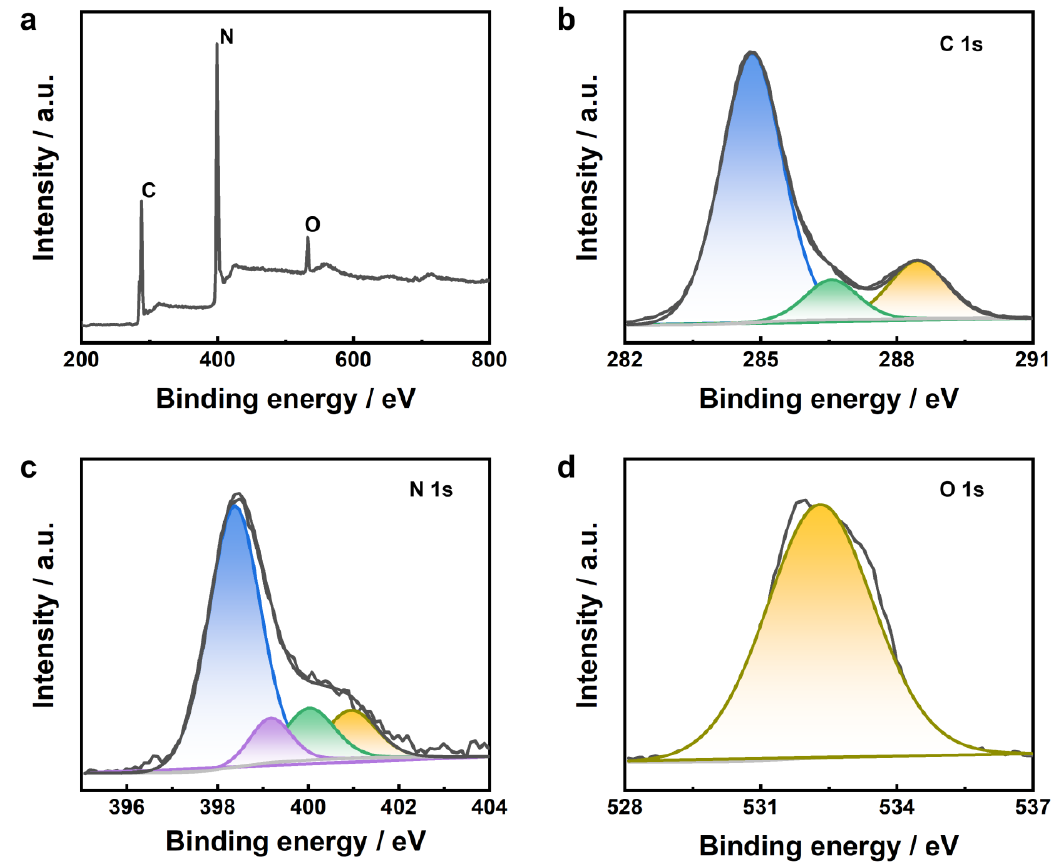
Figure 3. ( a ) Survey XPS spectra and ( b – d ) high-resolution XPS spectra of the CN/PANI heterojunc- tion film: ( b ) C 1s, ( c ) N 1s, and ( d ) O 1s.